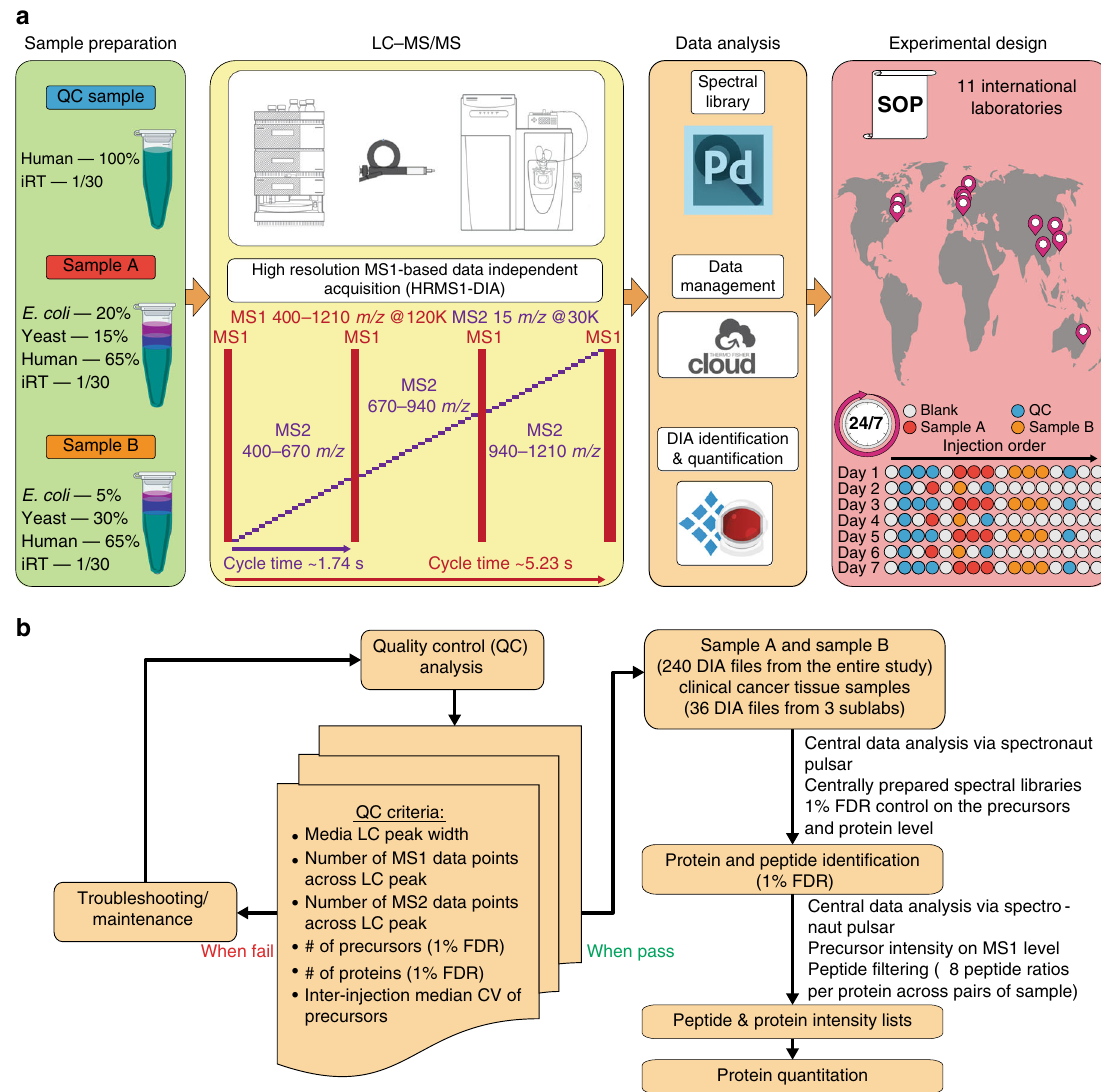
Fig. 1 Data acquisition and analysis using a streamlined HRMS1-DIA work fl ow. a The quality control (QC) sample was a HeLa lysate digest. The controlled samples A and B were mixtures of HeLa, yeast, and E. coli lysates. The samples were analyzed by capillary LC-HRMS1-DIA on a Q Exactive HF system at eleven sites in a 24/7 mode for seven consecutive days. On days 1, 3, 5, and 7, all samples were run in three technical replicates; on days 2, 4, and 6, samples A and B were each run once, and the QC standard was run once before and after samples A and B. The rest of the time, the instruments were running blank injections. White circles are blank injections, blue circles are QC injections, red circles are Sample A injections, and orange circles are Sample B injections. b Quality control criteria were based on the evaluation of the performance of the capillary LC-HRMS1-DIA work fl ow before the 11 labs began the study (Supplementary Table 1). During the study, a QC standard was analyzed in three technical replicates on days 1, 3, 5, and 7. If the QC criteria were met, sample A and sample B data sets acquired on the same day were analyzed. If the QC standard analysis did not pass QC criteria, either instrument setup maintenance or troubleshooting were undertaken. In total, 240 DIA fi les from both sample A and sample B were centrally analyzed